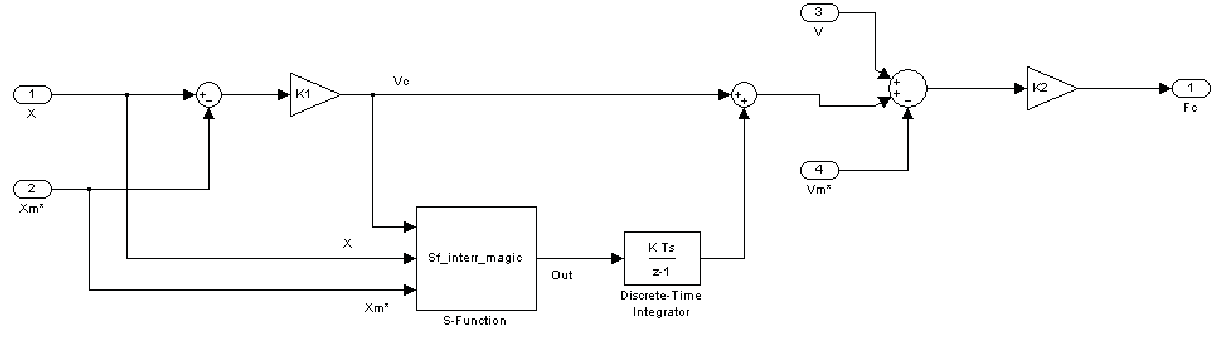
Figure 15. “Force Controller” block.